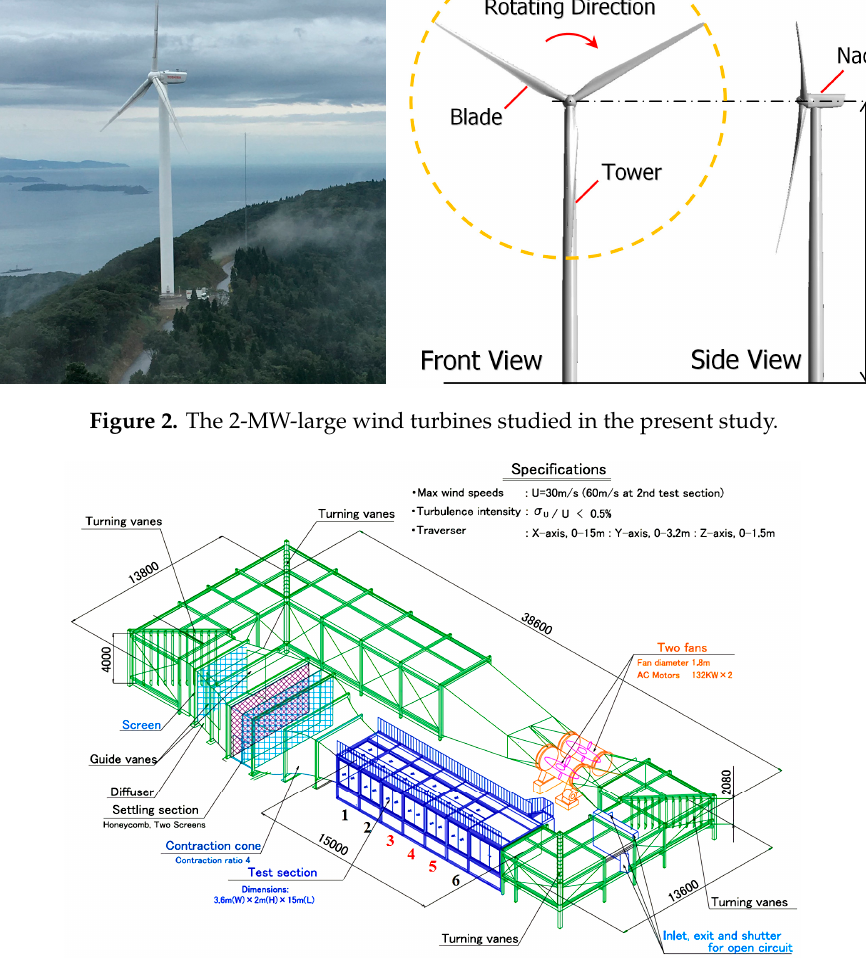
( b ) Figure 4. The 1/88 wind turbine scale model used in the present study. ( a ) Front view; ( b ) rear view. Figure 5. Relationship between the tip speed ratio (TSR; horizontal axis) and the power coefficient Cp. (vertical axis) of the 1/88 scale wind turbine model obtained in the wind tunnel experiment.